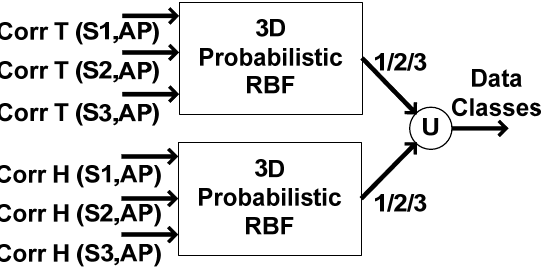
Figure 16. 3D RBF classification diagram.